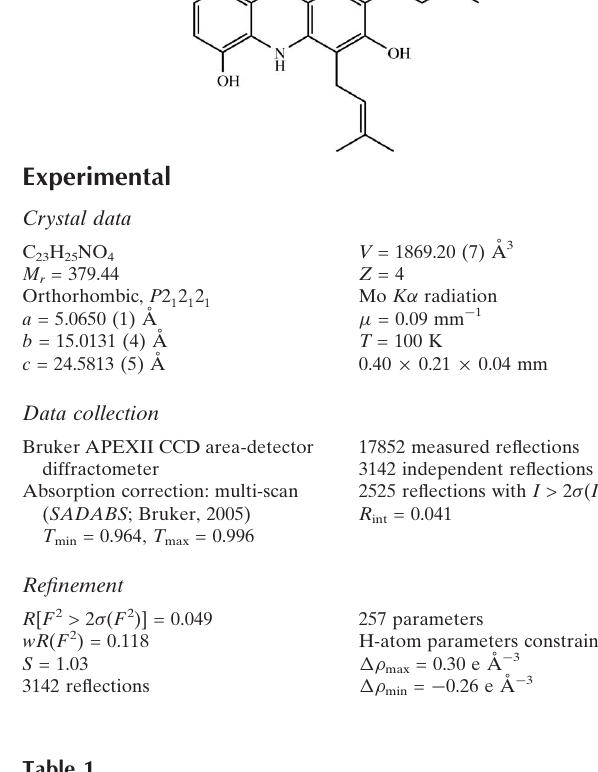
Hydrogen-bond geometry (A˚ , (cid:5)